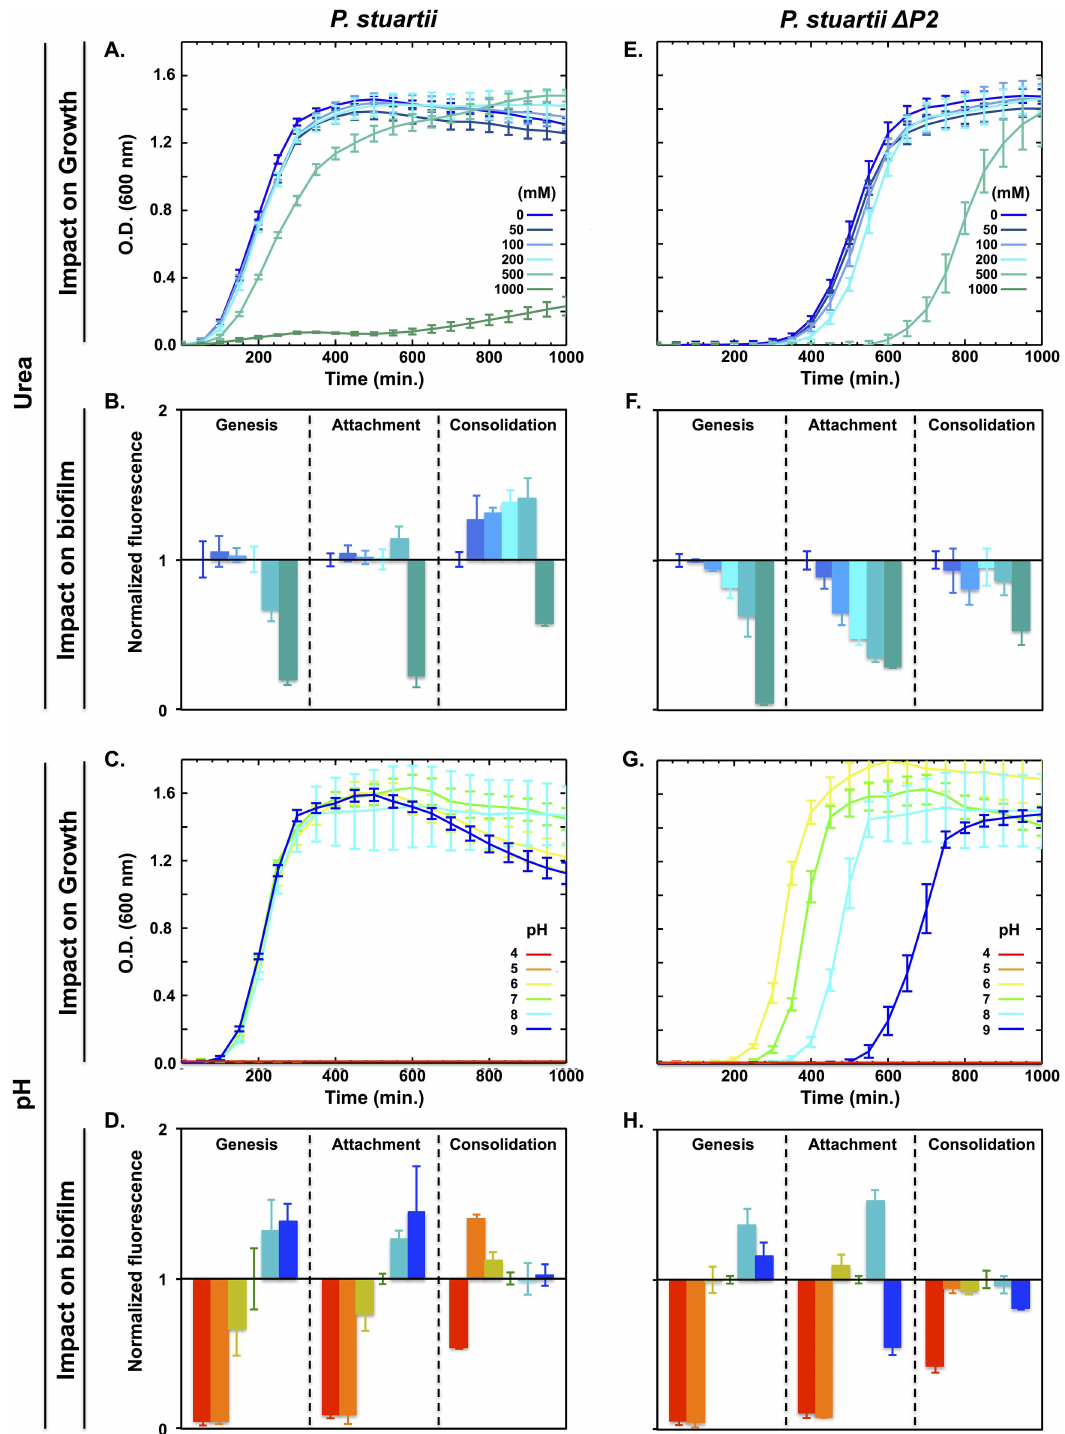
Fig 4. Resistance of P . stuartii and P . stuartii Δ P2 cells to high concentrations of urea and to pH variations. Effect of urea (A and E) and pH (C and G) on bacterialgrowth, as judgedfrom the O.D. of cultures at 600 nm. The impact on biofilm genesis,attachment and consolidation was evaluatedby addingurea (B and F) or changing the pH (D and H) duringthe lag, stationary and preformed biofilm phases, respectively.Biofilm formation was quantified 24 h later, by PrestoBlue staining. Fluorescence values were normalized with respect to the control wells containingno urea and buffered at pH7.